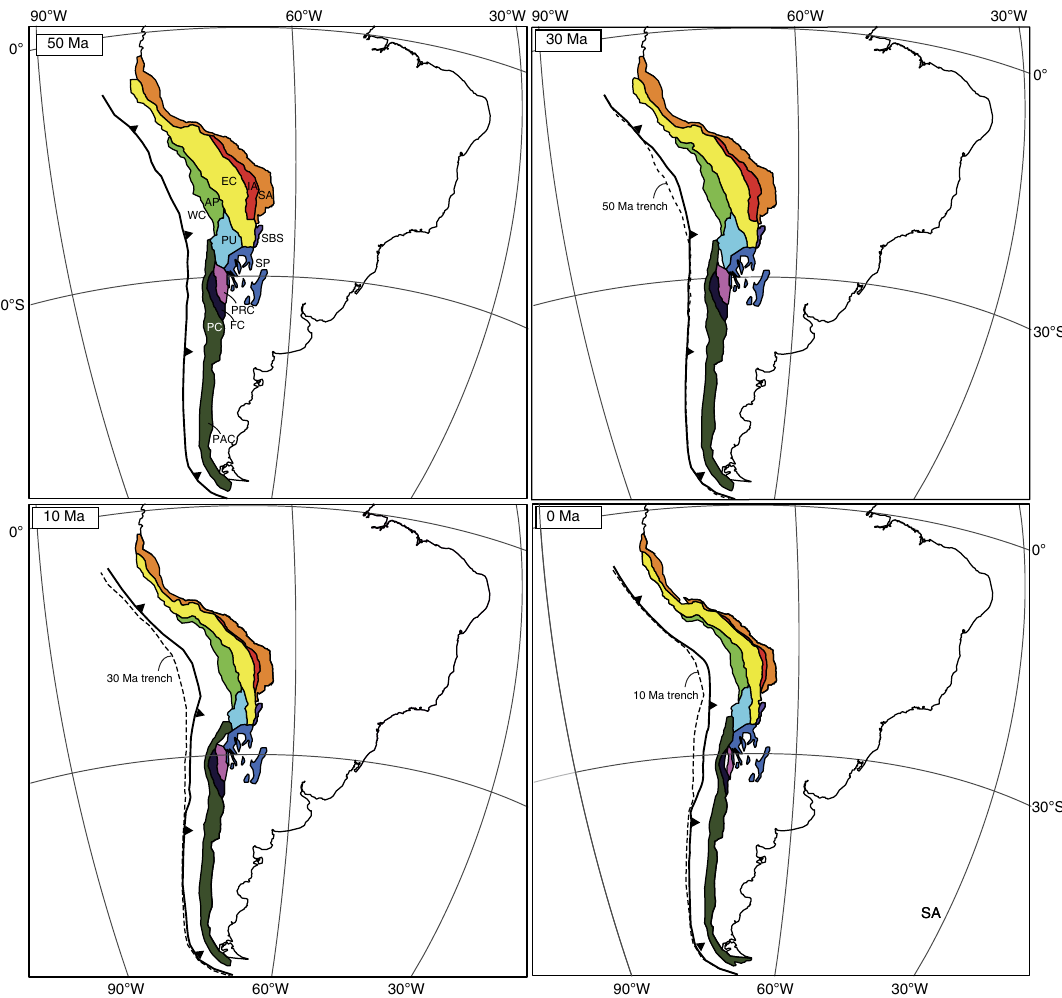
Figure 3 | Reconstruction of the Andes and South American trench. Reconstruction at at 50, 30, 10 and 0Ma in a South America fixed frame. AP, Altiplano Plateau; EC, Eastern Cordillera; FC, Frontal Cordillera; IA, Interandes; PAC, Patagonian Cordillera.; PC, Principal Cordillera; PRC, Precordillera; PU, Puna Plateau; SA, Subandes; SBS, Santa Barbara System; SP, Sierras Pampeanas; WC, Western